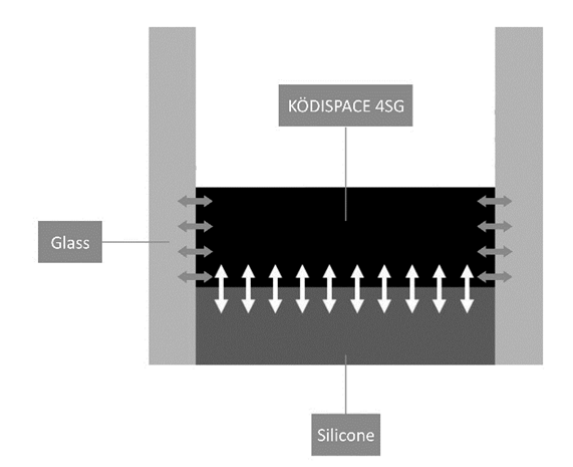
Fig. 2 Sketch of the chemical bonding of Ködispace 4SG to glass and